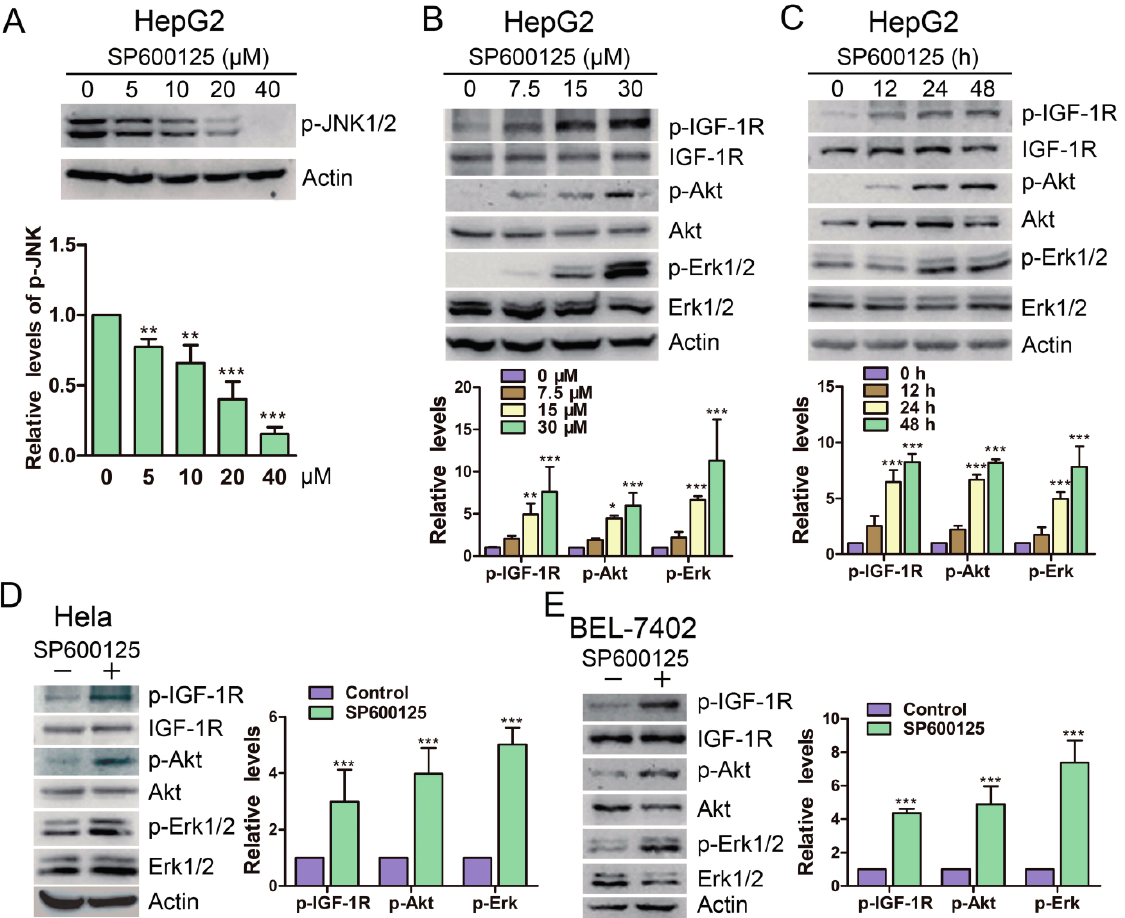
Figure 1. SP600125 induces type I insulin-like growth factor receptor (IGF-IR), Akt, Erk1/2 phosphorylation. ( A ) HepG2 cells were treated with increasing doses of SP600125 for 48 h, followed by western blot analysis of c-Jun N -terminal kinases (JNK) phosphorylation; ( B ) HepG2 cells were treated with SP600125 for 48 h at the indicated doses, followed by western blot analysis of phosphorylated IGF-1R, Akt, Erk1/2 and total IGF-1R, Akt, Erk1/2; ( C ) HepG2 cells were treated with 15 µM SP600125 for indicated periods, followed by western blot analysis of phosphorylated IGF-1R, Akt, Erk1/2 and total IGF-1R, Akt, Erk1/2; and ( D , E ) Hela and BEL-7402 cells were treated with 15 µM SP600125 for 48 h, followed by western blot analysis of phosphorylated IGF-1R, Akt, Erk1/2 and total IGF-1R, Akt, Erk1/2. The blots were subjected to densitometric analysis and relative quantification. Levels in SP600125-untreated cells were set as 1. A representative of three experiments was shown. * , p < 0.05; ** , p < 0.01; *** , p < 0.001, compared with control